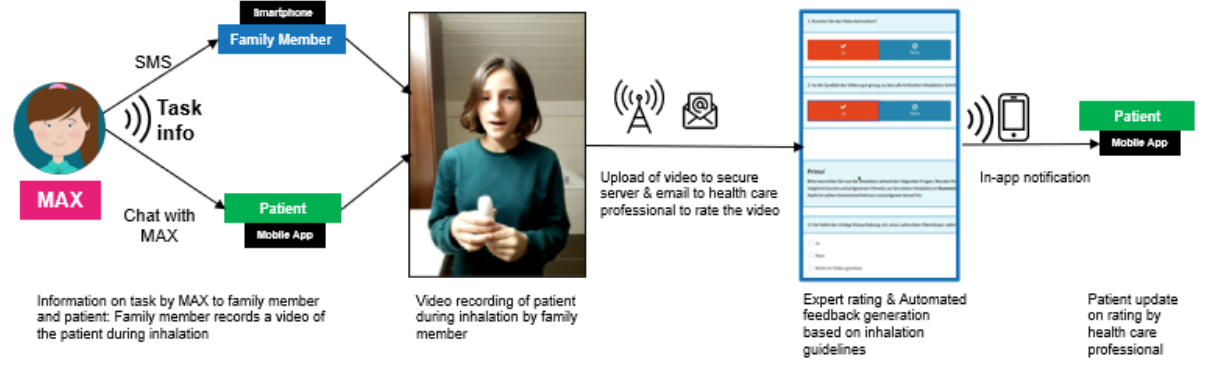
Figure 3. The MAX intervention integrates patients, family members, and health care professionals, and allows a ubiquitous experiential learning experience. An example of session 1 is shown here, in which patients were prompted by the MAX conversational agent to record a video of themselves during inhalation with the help of their support family member, who were additionally informed about the task via SMS text message. Once patients had created and uploaded the video to a secure server, health care professionals received an email to assess the video clip with regard to inhalation mistakes. Patients received their final feedback with comments via in-app notification. See Multimedia Appendix 7 for a representative video